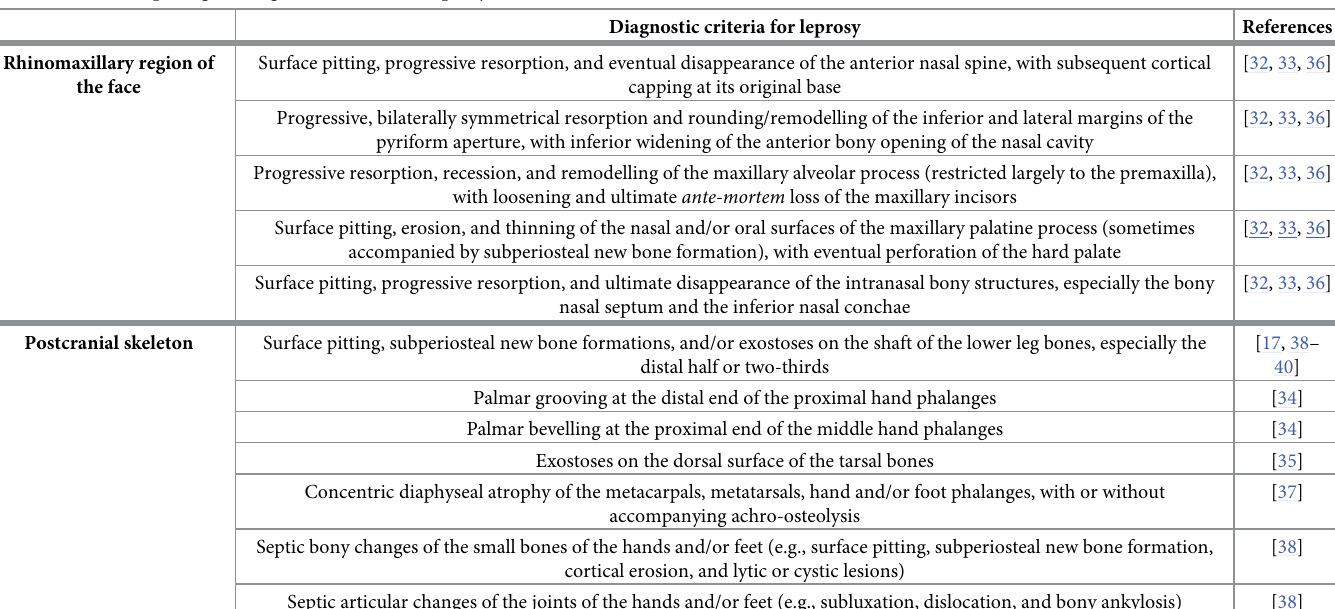
Table 1. Macromorphological diagnostic criteria for leprosy.